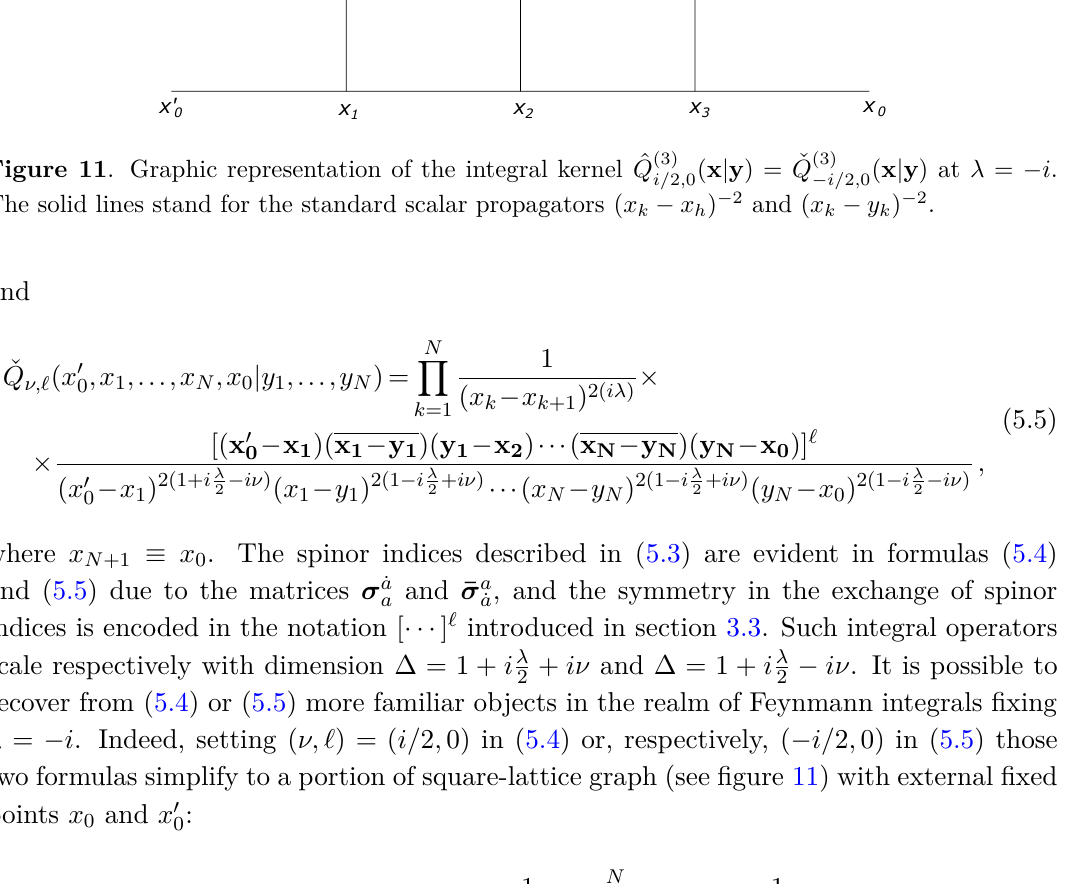
Figure 11 . Graphic representation of the integral kernel The solid lines stand for the standard scalar propagators ( x